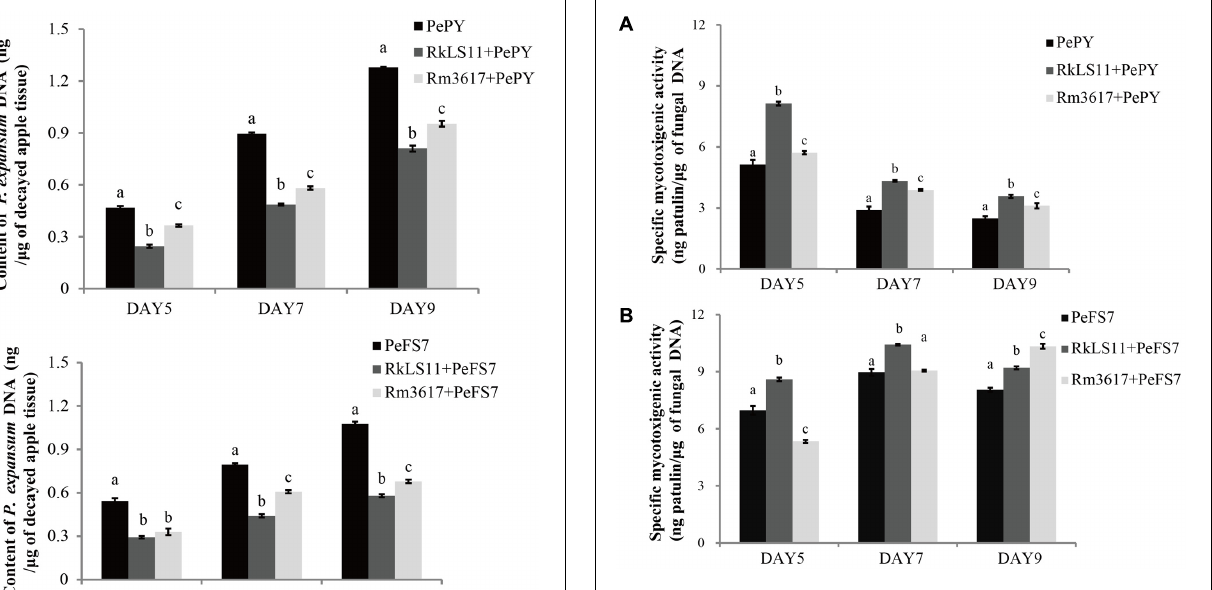
P. expansum PY in the presence of the yeast strain LS11, and